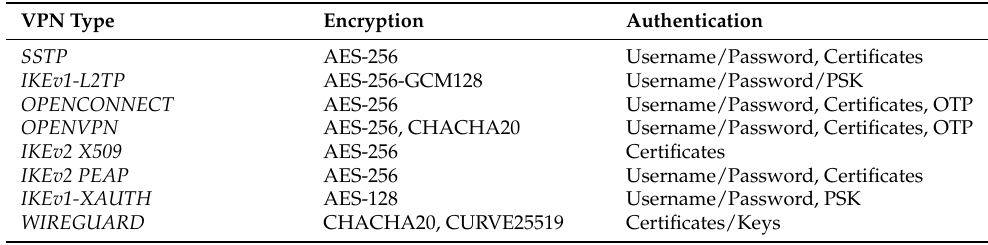
Table 4. Comparison table of Authentication and Encryption used in the experiments and proposed by default